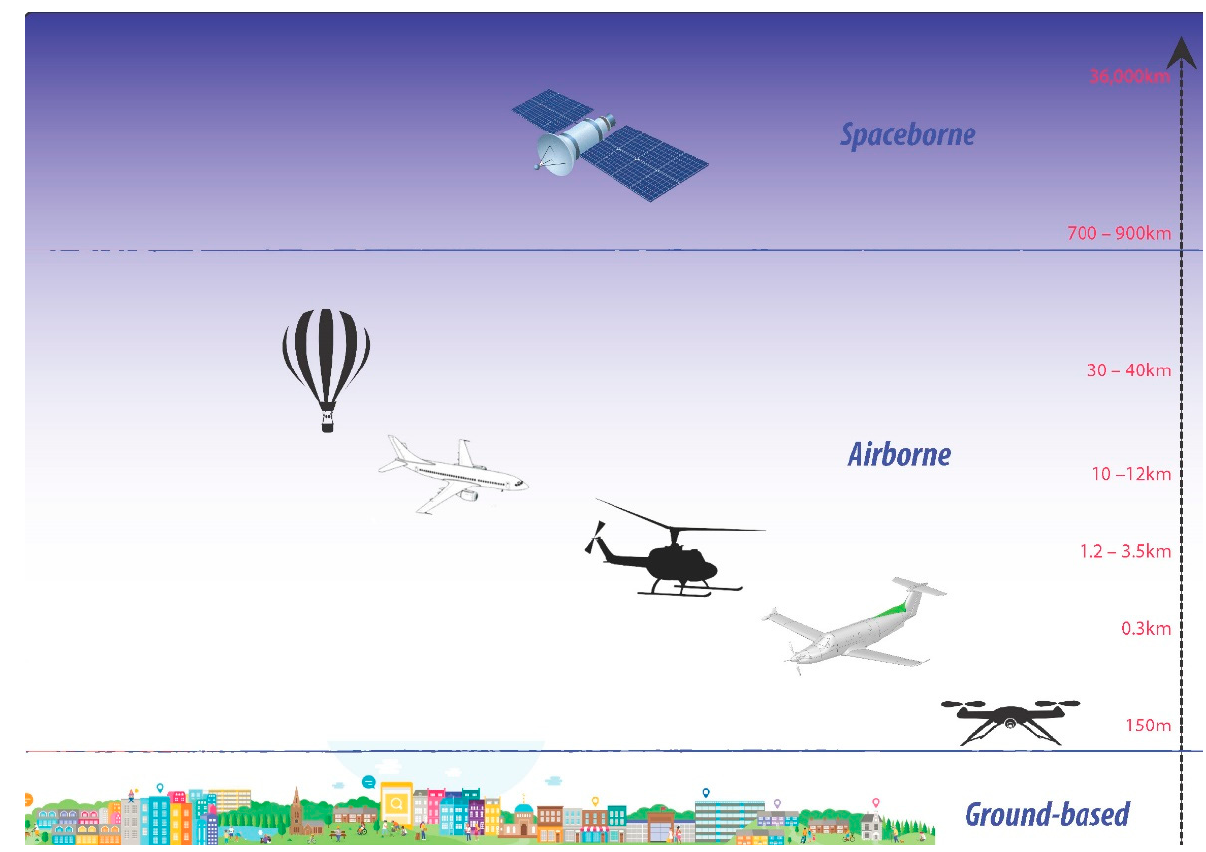
Figure 4. Categories of remote sensing platforms.